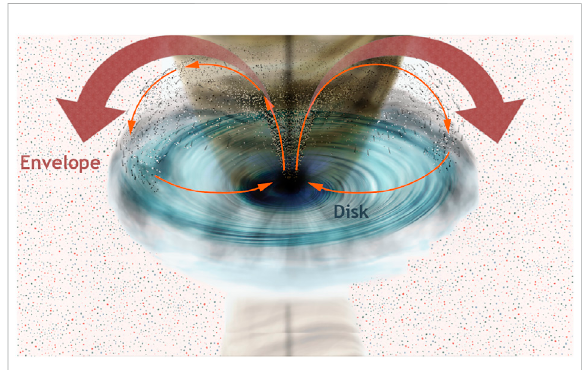
FIGURE 7 Artist impression of the dust growth and recycling from disk to envelope, thanks to out fl owing gas during the protostellar stage. Modi fi ed from an original illustration in Tsukamoto et al. (2021)